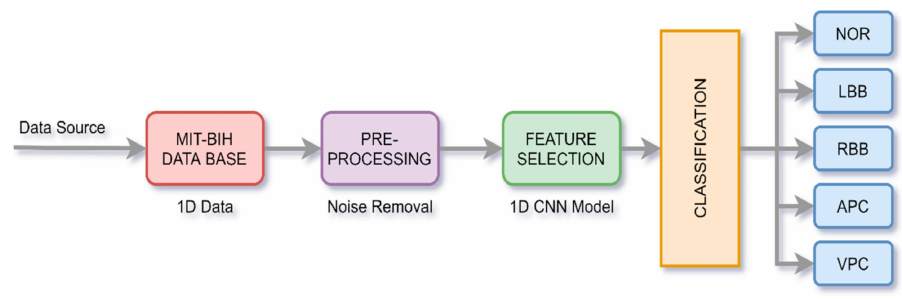
Figure 2. Process of ECG signal